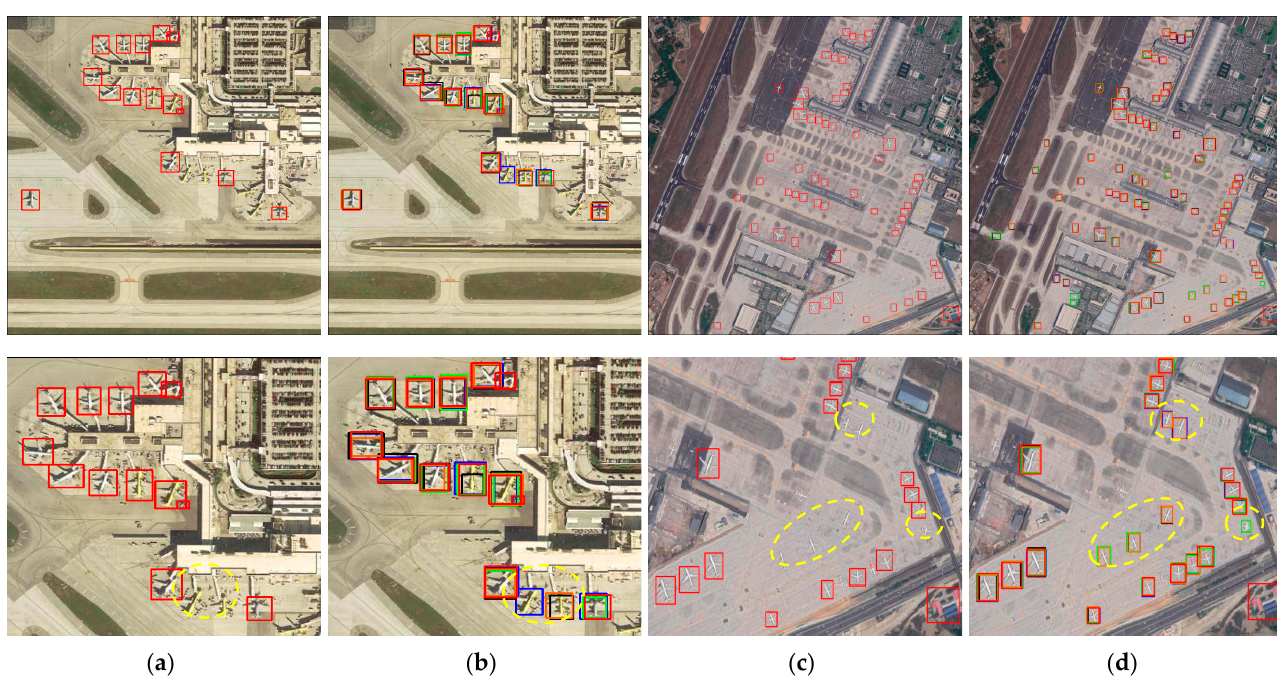
Figure 9. Comparison of detection results on test set (The second line are partial enlarge views and the yellow dashed ellipse is used to emphasize the changed area). ( a , c ) Results of Faster R-CNN. ( b , d ) Results after multi-angle features driven strategy (different color boxes represent the preliminary detection results). ( a , b ) Dataset II. ( c , d ) Dataset III.